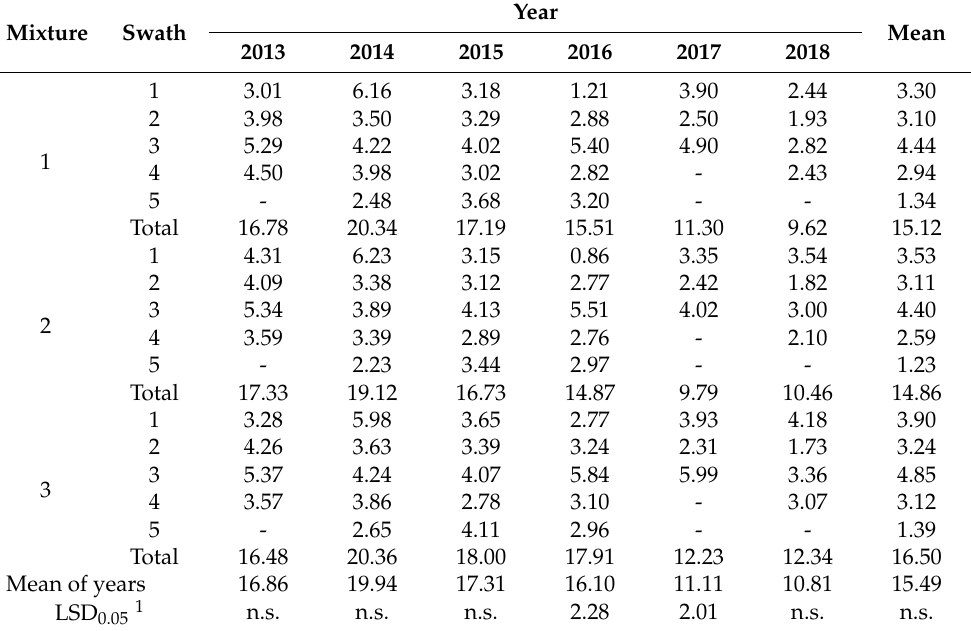
Table 8. Dry matter yield in t · ha − 1 from experiment III.